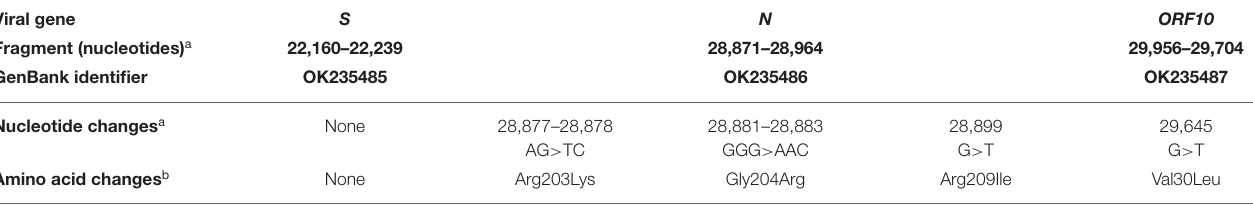
TABLE 2 | Differences in the partial gene sequences found here with the SARS-CoV-2 reference sequence. Viral gene S N Fragment (nucleotides)